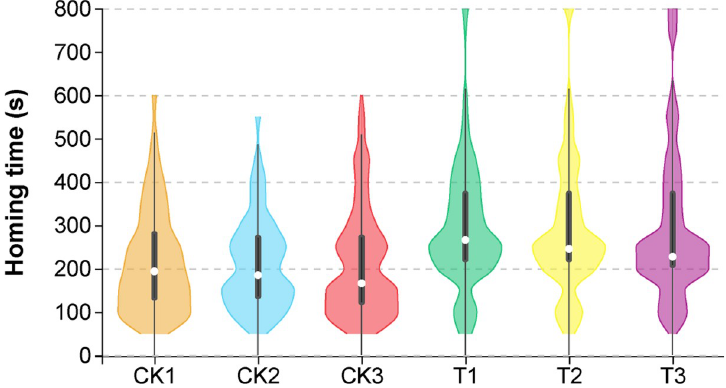
Fig 2. The effect of T . mercedesae infestation on homing ability of adult honey bee. Violin plot shows the homing time in control bees and T . mercedesae infested bees (n = 56–96). Horizontally, the width of each violin box represents the density of the data values. The white dots represent the median values of each group. The upper and lower edges of the black thick line represent the 3/4 digits and 1/4 digits of the data. The upper and lower ends of the thin line represent the maximum and minimum values of non-outliers of the data. CK: non-infested honey bees; T: T . mercedesae -infested honey